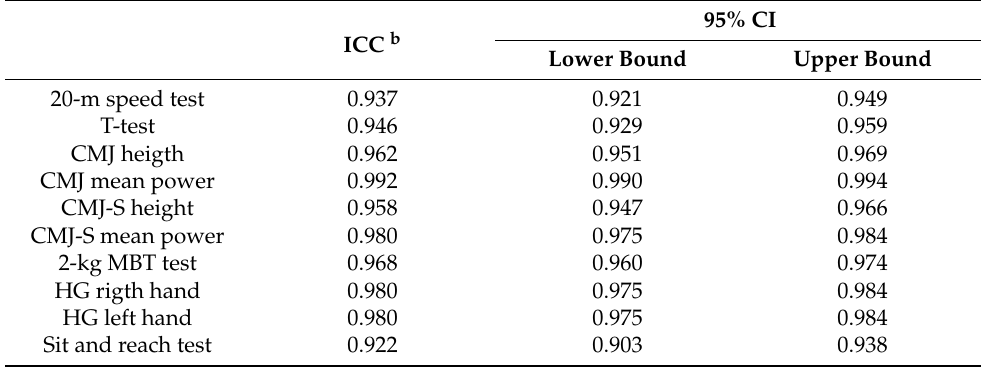
Figure 1. Distribution of self-reported data (Portuguese Health Card) and performed data (cohorts). Frequency of cases by age. Table 1. Intraclass correlation statistics for inter-rater reliability for the physical